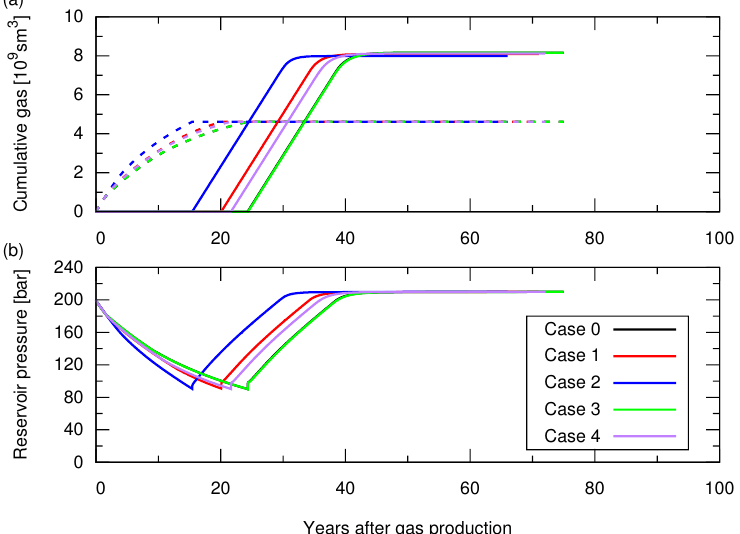
Figure A1. Simulation results of the CO 2 injection following the hydrocarbon gas production for cases 0 to 4; the influence of the reservoir heterogeneity was studied in Section 3.1 of the main text. See Table A1 for the descriptions of these cases. ( a ) Cumulative amount of produced CH 4 in the dotted lines and cumulative amount of injected CO 2 in the solid lines; ( b ) Average pressure at the datum depth of 2015 m as a function of